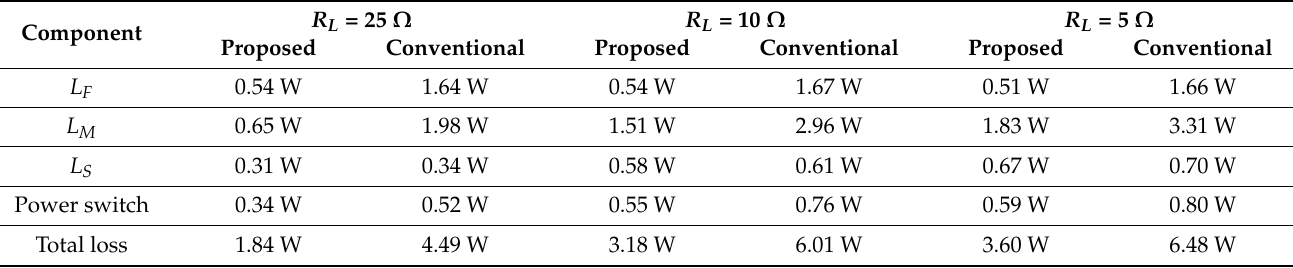
Table 4. Component losses of the class Φ 2 inverter.